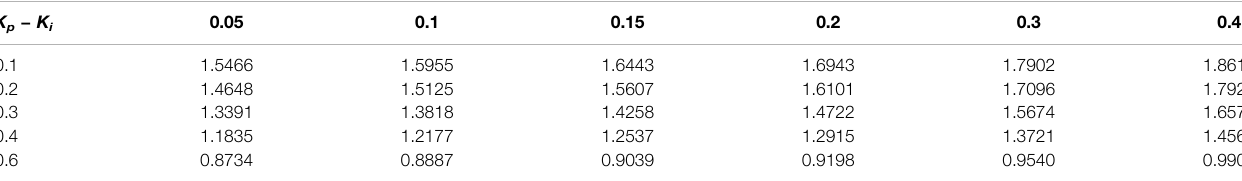
TABLE 4 | Delay margins for K d (cid:2) 0.2.